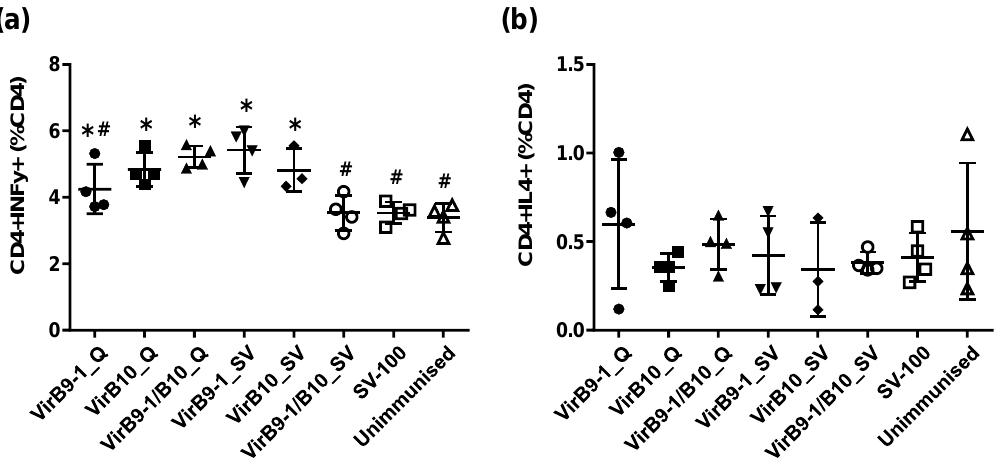
Figure 8. FACS analysis of mice ( n = 4) spleen T lymphocyte sub-populations after re-stimulation with VirB10 protein for 3 h. ( a ) Cell populations with Th1 phenotype in treatment groups after re-stimulation. Groups marked with # show significant differences ( p < 0.05) from the groups marked with * . VirB9-1_Q shows no significant differences with any other group ( *# ); ( b ) Cell populations with Th2 phenotype in treatment groups after re-stimulation, no significant differences are seen ( p < 0.05).